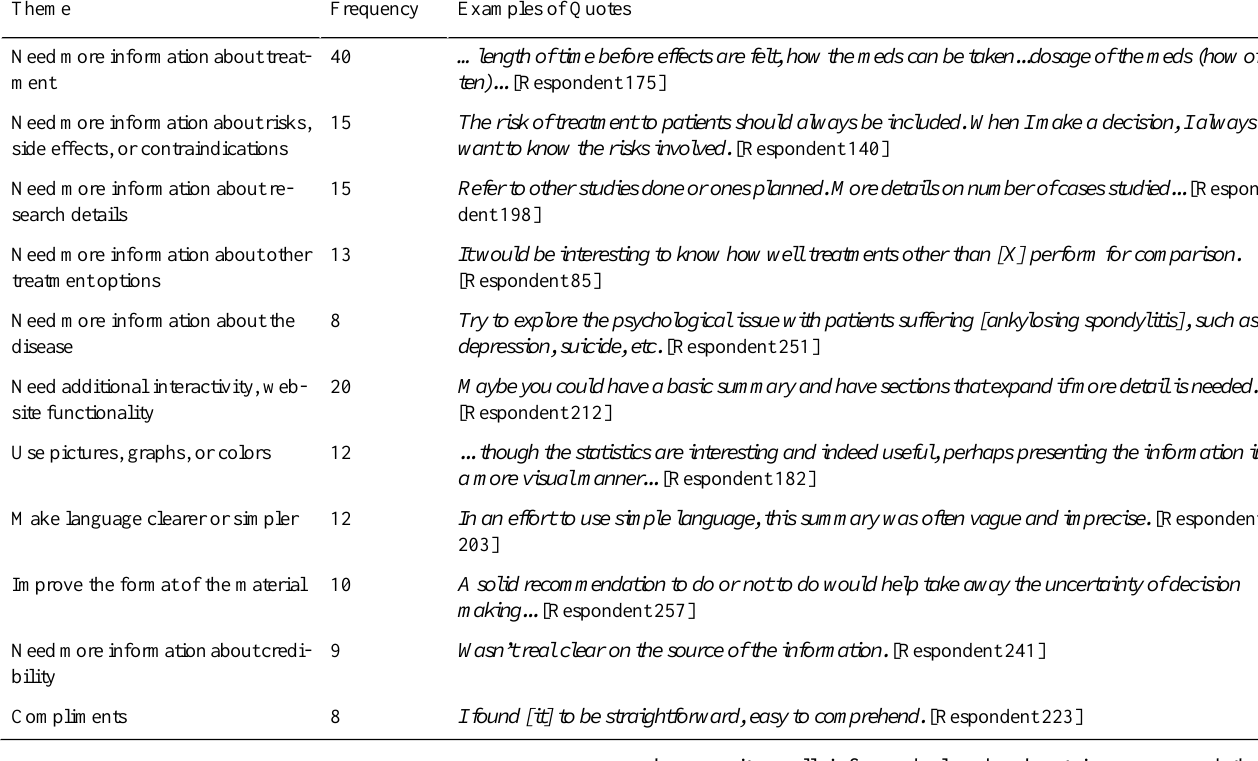
Table 6. Frequency of themes and examples of theme-relevant quotes of respondents’impressions of the summaries (n = 131) Examples of QuotesFrequencyTheme …length of time before effects are felt, how the meds can be taken...dosage of the meds (how of- 175]40Need more information about treat- ten)... [Respondent